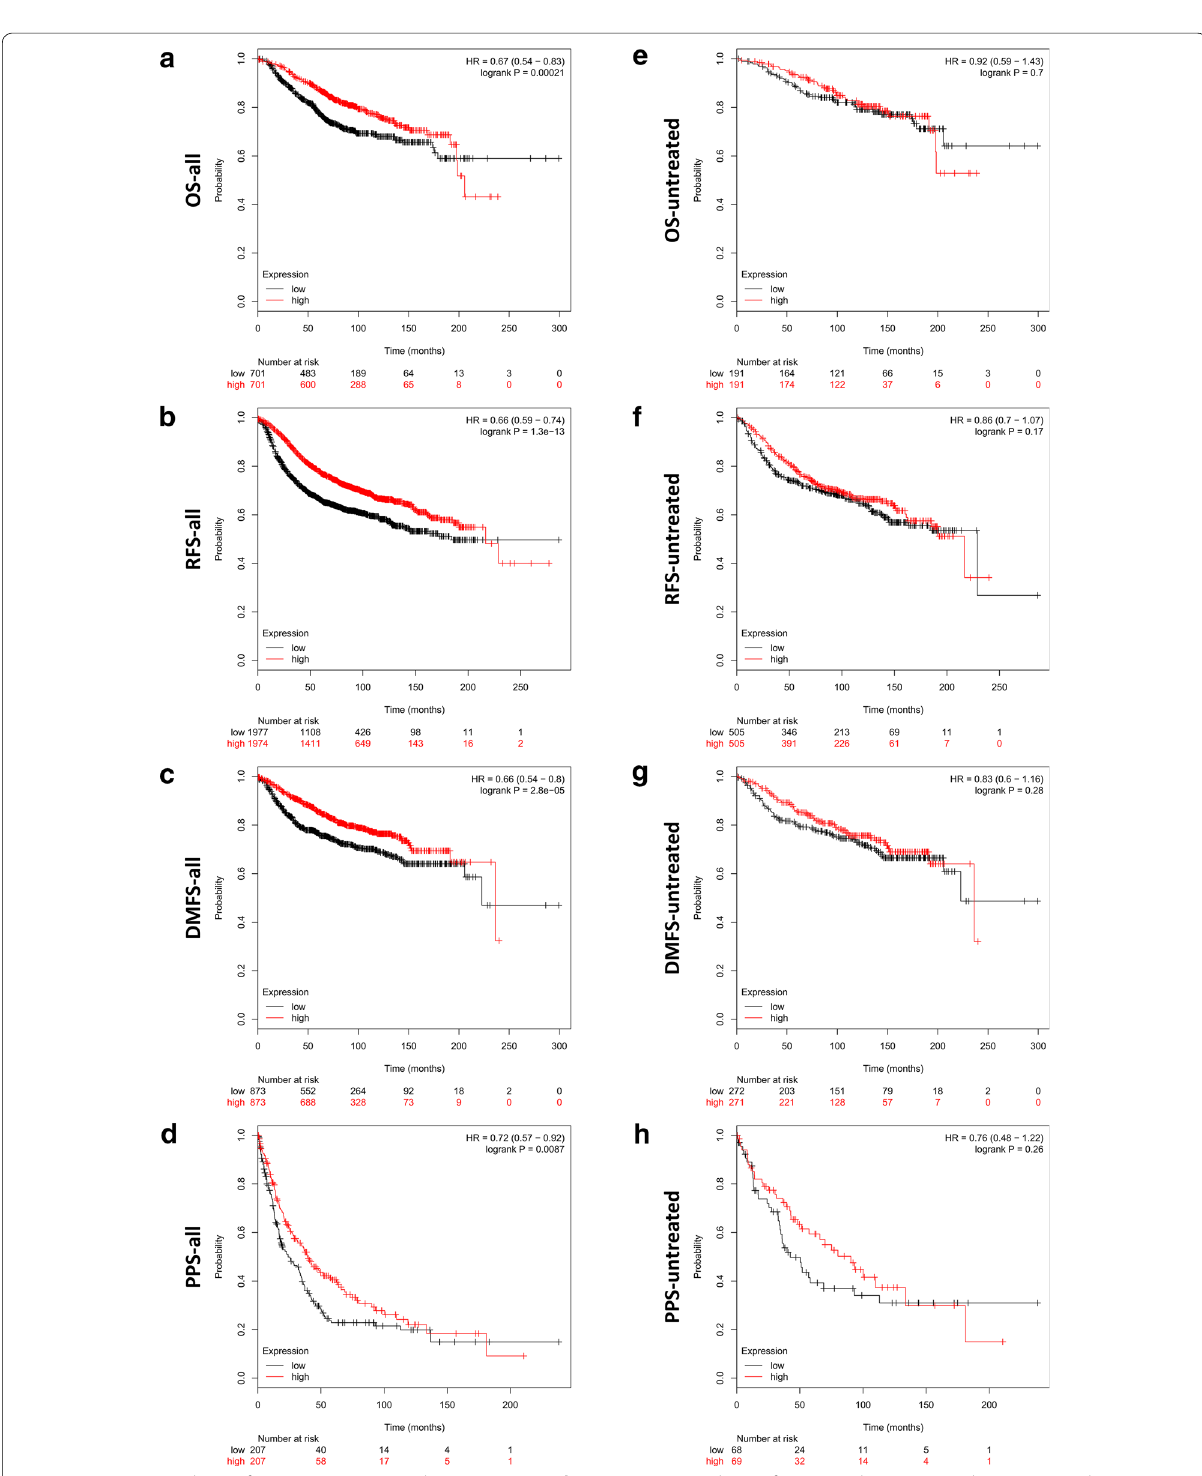
Fig. 1 Prognostic analyses of CYP19A1–ESR axis in breast cancer. a – d OS, RFS, DMFS and PPS of integrated CYP19A1 and ESR1/ESR2 in breast cancer patients (n 1402 in OS, 3951 in RFS, 1746 in DMFS, 414 in PPS respectively). e – h OS, RFS, DMFS and PPS of integrated CYP19A1 and ESR1/ = ESR2 in untreated breast cancer patients (n 382 in OS, 1010 in RFS, 543 in DMFS, 137 in PPS respectively). The detailed HR and logrank p-value = were individually shown as indicated in each panel, and p-value < 0.05 was considered statistically